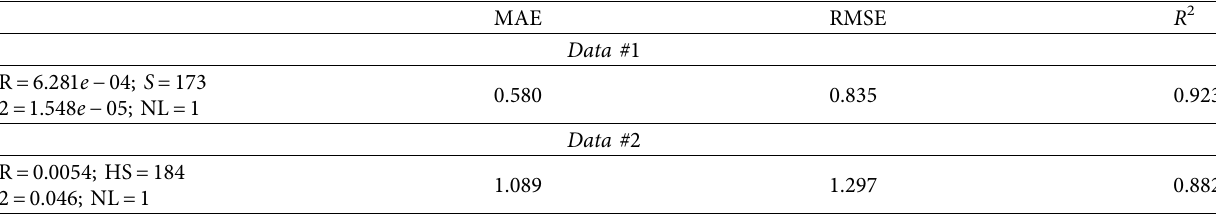
Table 5: Efects of Bayesian optimization super parameters on the